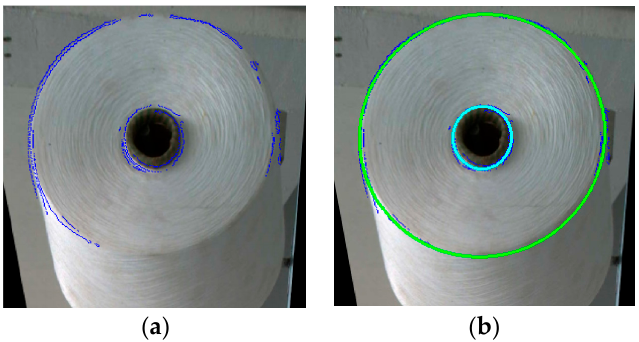
Figure 12. Points sifted and ellipse fitting. ( a ) Points after sifted. ( b ) Ellipse fitting.